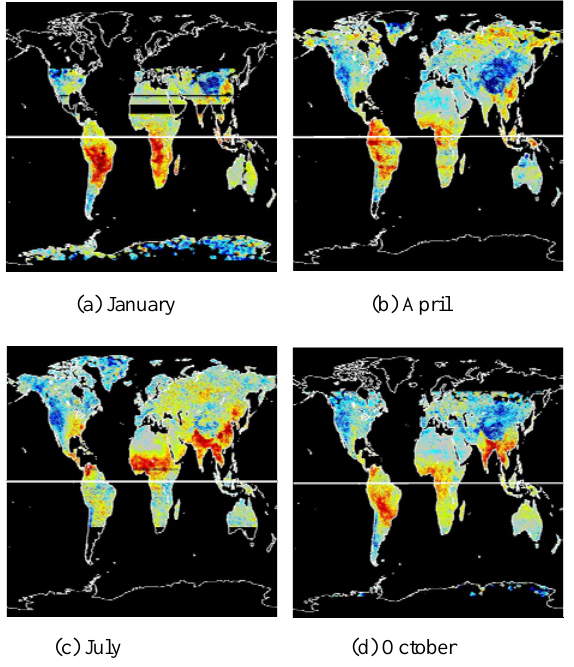
Figure 6. Time-series CH 4 emission concentration over continental